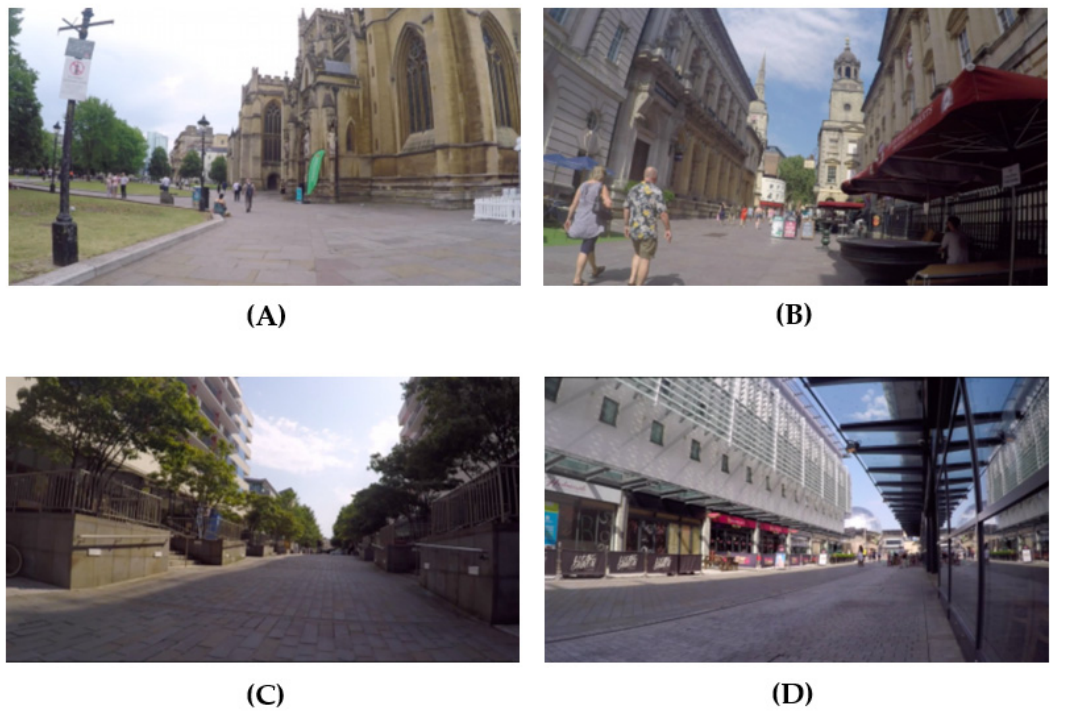
Figure 1. Visual stimuli for environment conditions: ( A ) green historic; ( B ) non-green historic; ( C ) green modern; ( D ) non-green modern.